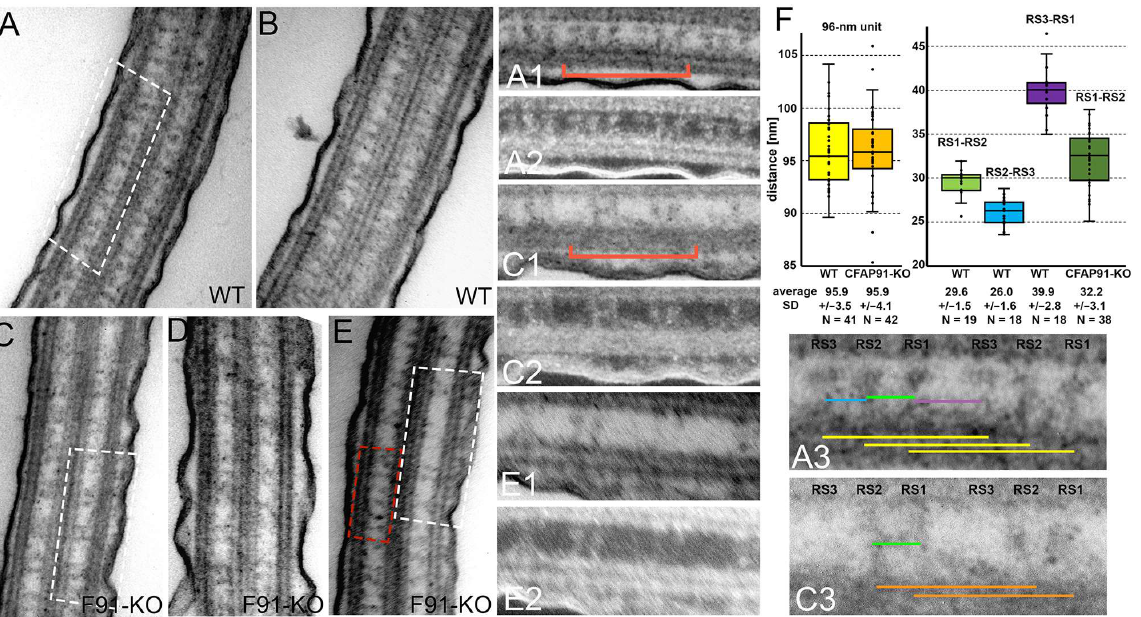
Figure 5. One of the radial spokes is lost in the subset of CFAP91-KO 96-nm ciliary units based on the classical transmission electron microscopy analyses. ( A – E ) Longitudinal sections of cilia of wild-type ( A , B ) and CFAP91-KO cells ( C – E ). A red rectangle box in ( E ) indicates a region where radial spokes are close to each other (no apparent triplets visible). ( A1 , A2 , C1 , C2 , E1 , E2 ) Magnified fragments of the axonemes are marked by white rectangle boxes in A , C , and E , respectively. ( A2 , C2 , E2 ) Reverse contrast images of the images presented as ( A1 , C1 , E1) , respectively ( A3 , C3 ) Magnified fragments of the wild-type ( A3 ) and mutant ( C3 ) axonemes (marked by a red bracket in A1 , C1 , respectively) showing two adjacent radial spoke triplets, ( F ) A graph representing measurements of the distances between radial spokes (as indicated by color lines in A3 , C3 ) in wild-type and CFAP91-KO mutant